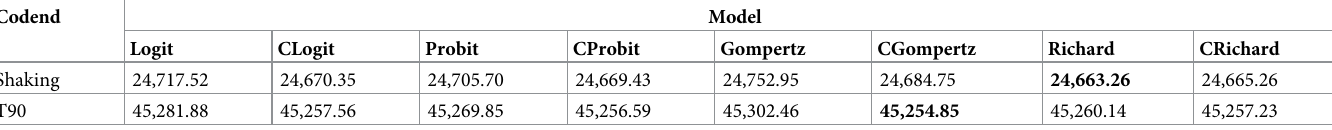
The drag forces measured for the T90 codend at the flow velocity of 1.0 kt suffered a mechanical failure and were erroneous and were excluded from analysis. Thus, the difference in drag forces between the shaking and T90 codends was only compared at the flow velocities of 1.2–1.8 kt. The best model contained codend, flow velocity, and their interaction term (S1 Table). The model showed that the shaking codend had a higher overall drag force (S2 Table). A subsequent Tukey’s HSD post hoc test showed that the mean drag forces generated by the shaking codend were significantly higher than those generated by the T90 codend at each cor- responding flow velocity ( p -value < 0.001; Fig 5). The mean drag force of the shaking codend was significantly different among flow velocities and increased along with the flow velocity ( p - value < 0.001; Fig 5). Though codend drag was higher for the shaking codend, it should be considered that codend drag is only a small proportion of total gear drag [53], and that the observed higher drag would only have a minimal increase in total drag and fuel consumption. Recorded depths were used to generate amplitude ratio and period results, means are reported in Table 2. The best model for amplitude ratio included the codend, flow velocity, and their interaction term (S1 Table). The model showed that the amplitude ratios generated by the shaking codend were higher than those by the T90 codend (S2 Table). Post hoc analysis showed that for each tested flow velocity, amplitude ratio was higher for the shaking codend, slight but significant differences were observed between amplitude ratios for the shaking codend, and flow velocity did not affect the amplitude ratio for the T90 codend (Fig 5). For period, the data were first fitted with a generalized linear model (GLM) using a Poisson link function. The dispersion of the model was determined to be underdispersed; thus, a quasi-Poisson link was used. The best model contained codend, flow velocity, and their inter- action term (S1 Table), and showed that the T90 codend had a lower period (S2 Table). Post hoc analysis showed that the period of the shaking codend at each corresponding flow velocity was significantly higher than the T90 codend ( p -value < 0.05; Fig 5). The period for each codend was highest at a flow velocity of 1.0 kt and gradually decreased, significantly, as flow velocity increased ( p -value < 0.05; Fig 5), except the period for the T90 codend between 1.6 and 1.8 kt ( p -value > 0.05; Fig 5). Table 5. AIC values for fit size selectivity